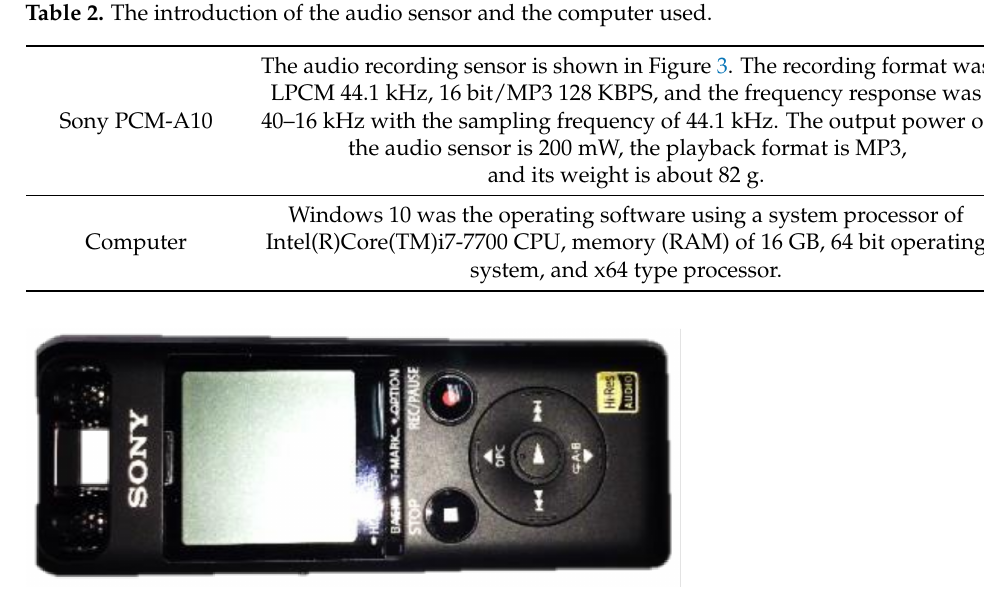
Figure 3. Signal acquisition by audio